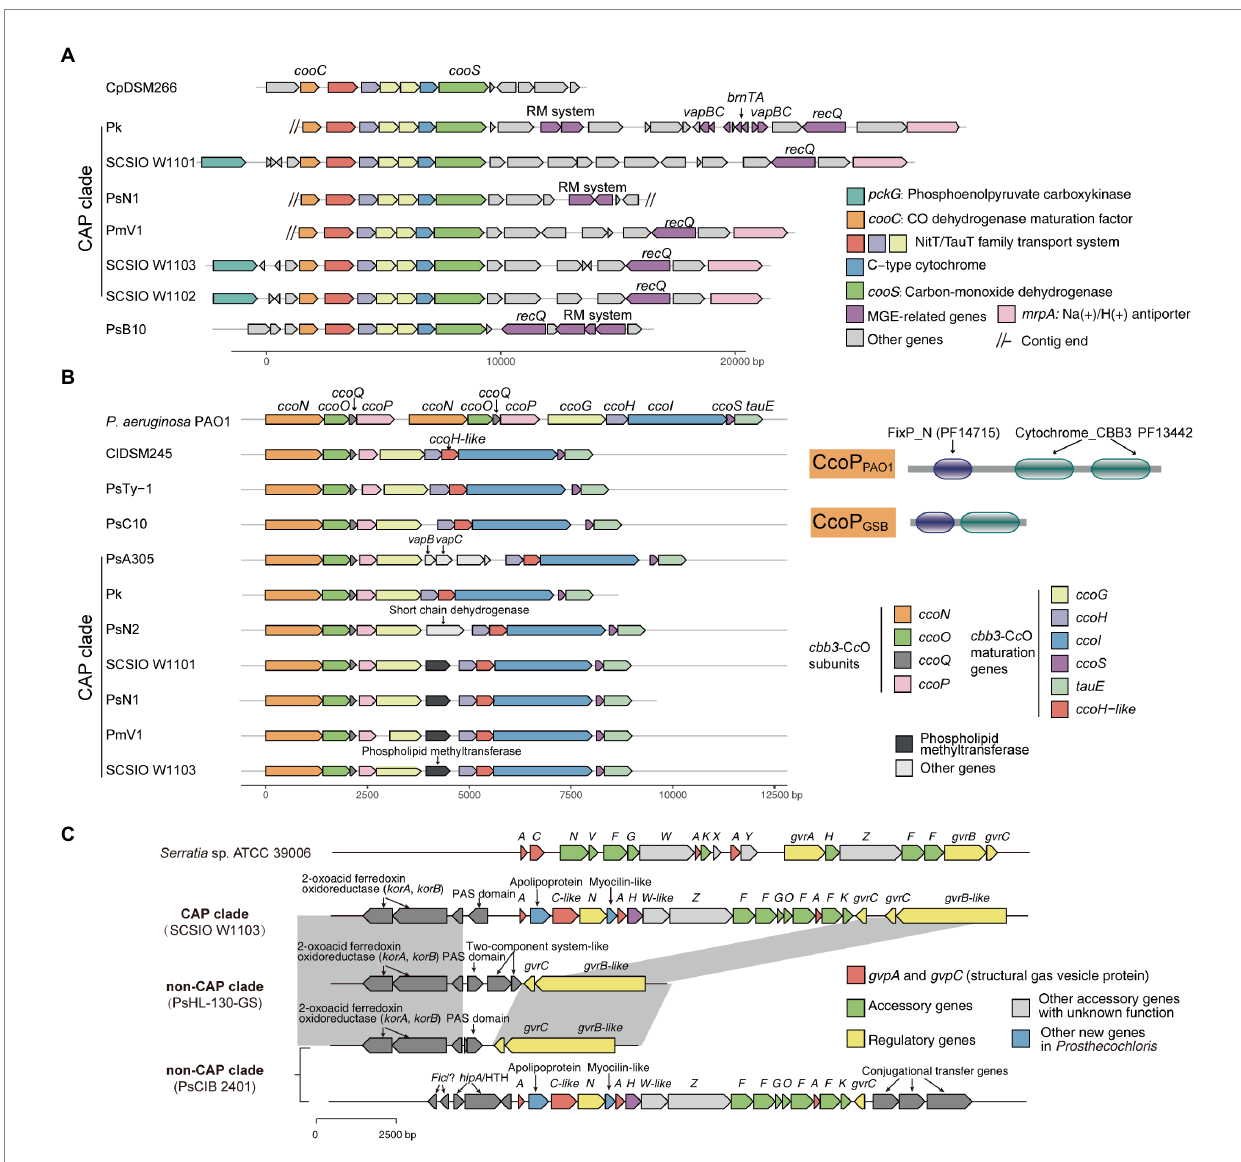
FIGURE 4 Mobile genetic elements and related genome rearrangements reshape gene clusters involved in the metabolic capacity divergence between coral- associated Prosthecochloris (CAP) and non-CAP genomes. (A) gene clusters of carbon monoxide dehydrogenase. (B) Gene clusters of cbb 3 -type cytochrome c oxidases ( cbb 3 -C c Os). The domain architectures of different CcoP proteins are shown. PF14715: FixP_N (N-terminal domain of cytochrome oxidase- cbb 3 FixP). PF13442: Cytochrome_CBB3 (Cytochrome C oxidase, cbb 3 -type, subunit III). (C) Gene clusters of gas vesicle proteins ( gvp ). Gray shading indicates conserved genomic